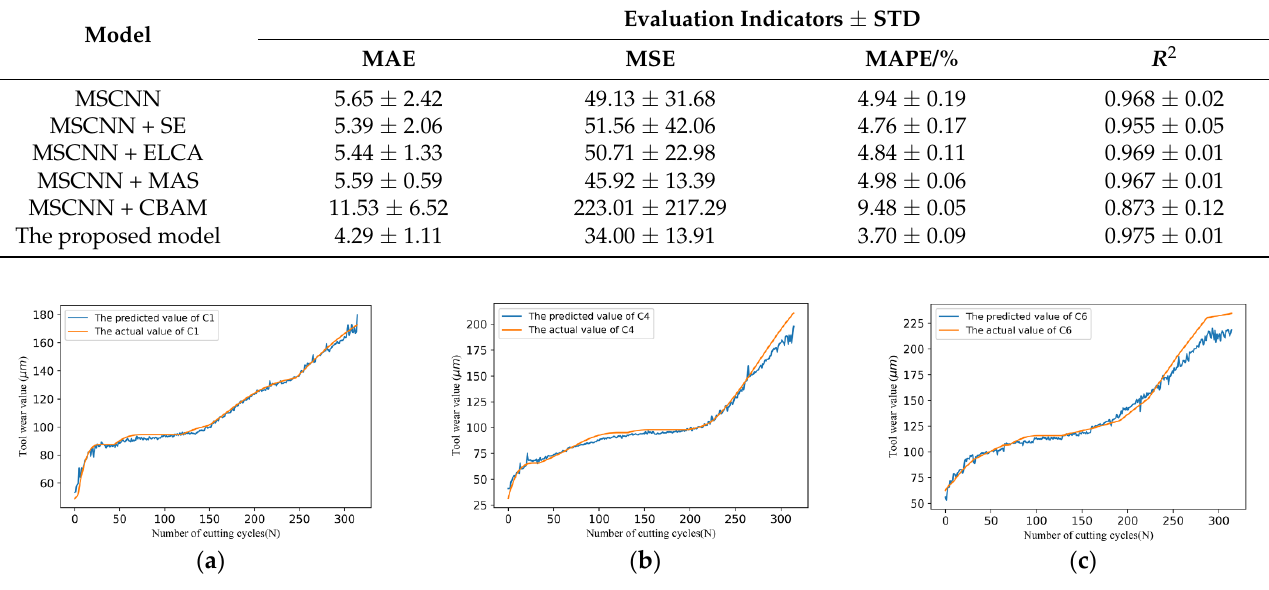
Table 2. Experimental processing parameters table.